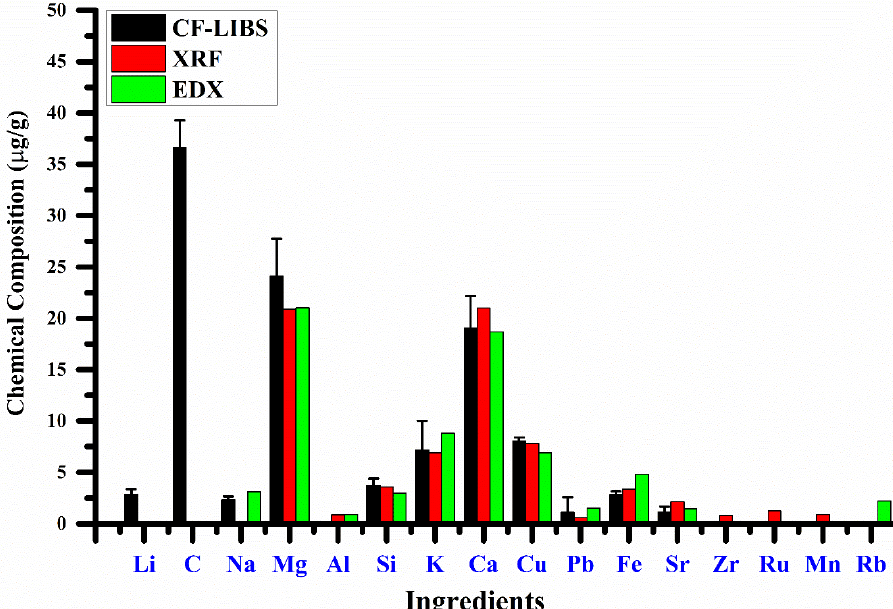
Figure 11. Chemical composition ( µ g/g) of the P. harmala seed sample-( α ) using the CF-LIBS, XRF, and EDX.